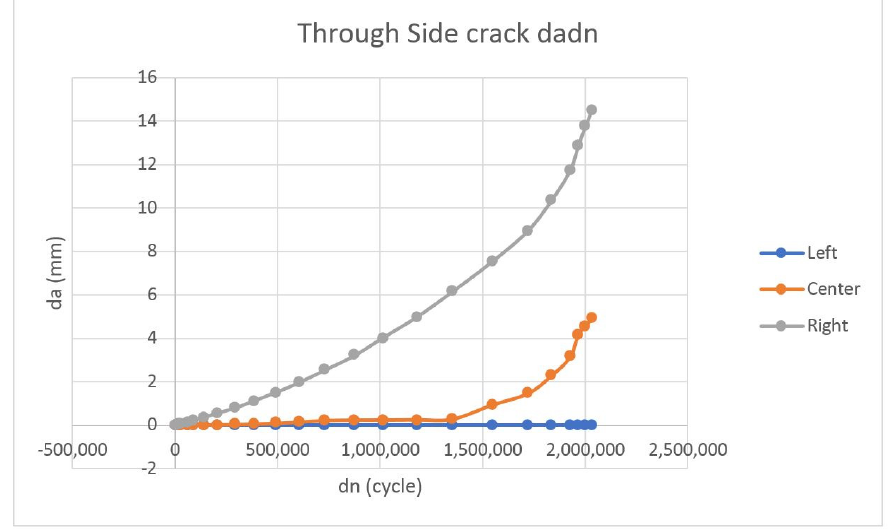
Figure 17. Cycle vs. the sum of d a for through side crack.